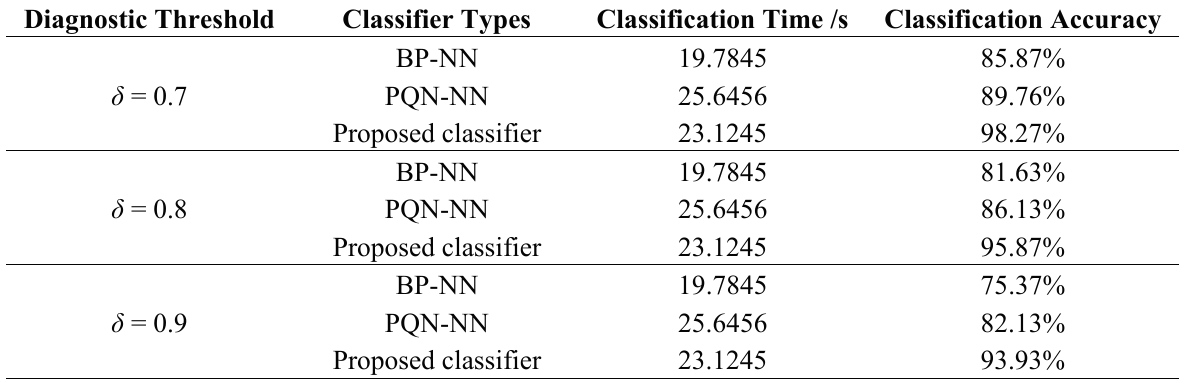
Table 8. Comparison of classification results through BP-NN, PQN-NN and the proposed classifier.